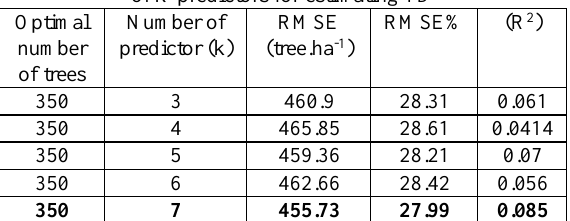
Table 3. The results of RF algorithm with different number of K predictors for estimating TD